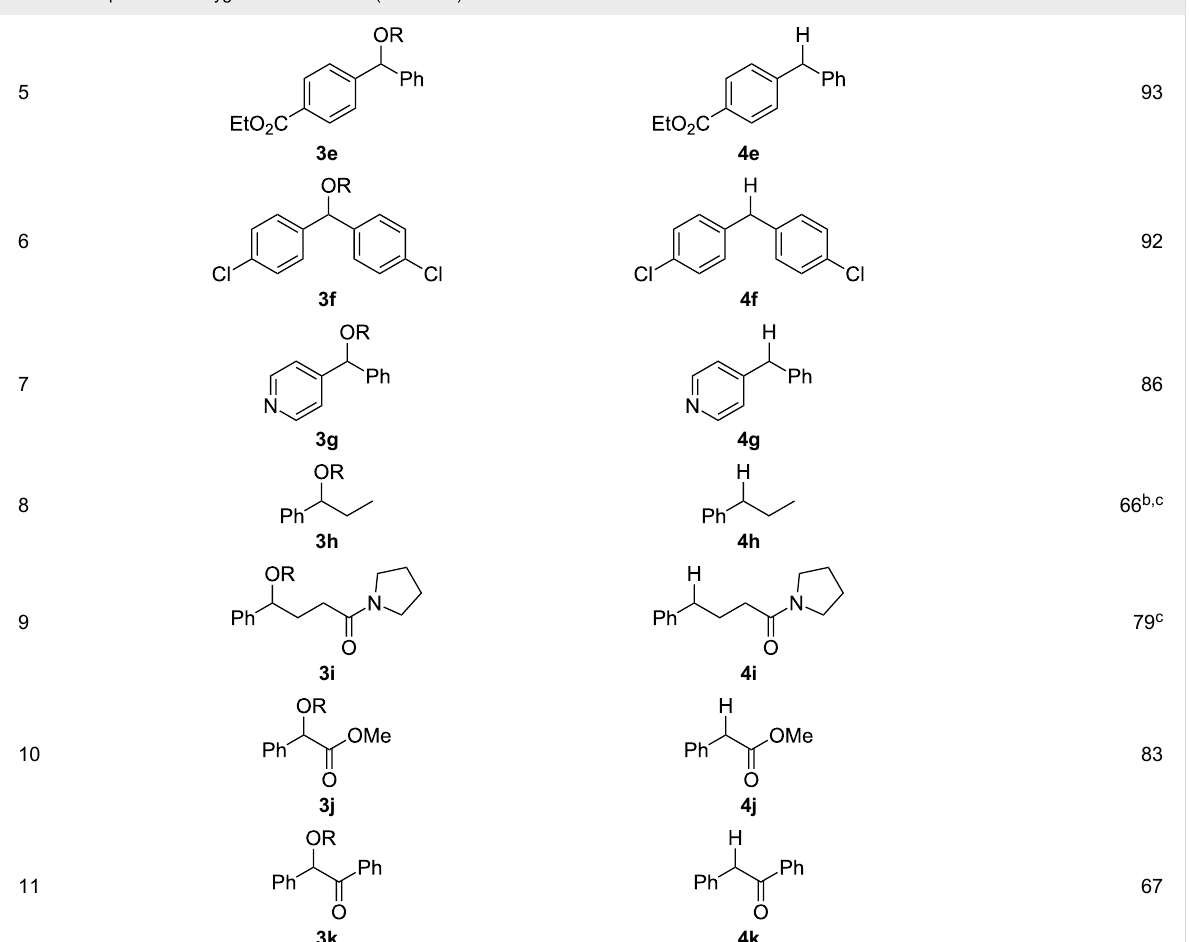
Table 3: Preparative deoxygenation reactions. (continued)